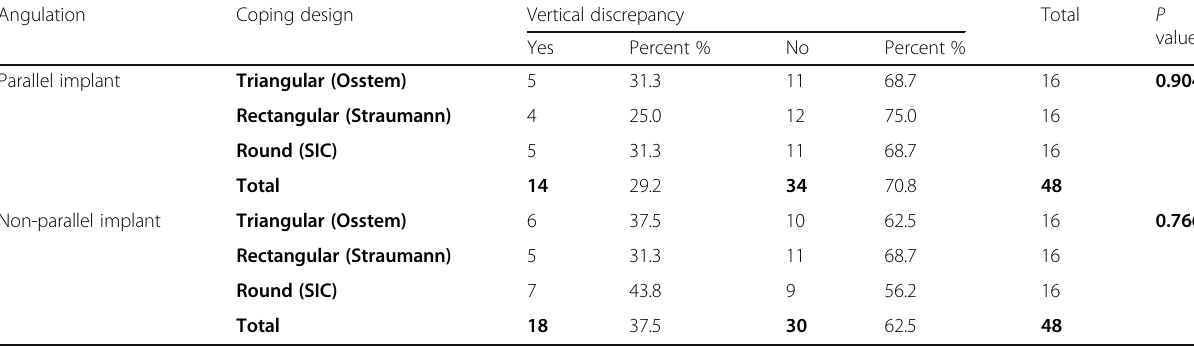
Table 7 Effect of implant angulation of the closed tray coping designs on the vertical discrepancy Angulation Coping design Parallel implant